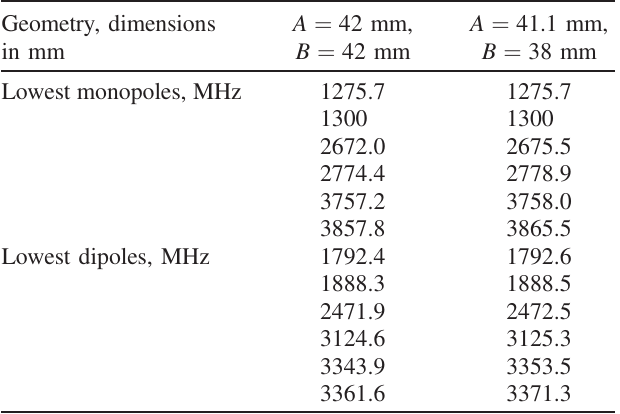
TABLE I. Frequencies of higher order modes for geometries specified in Fig. 8: original TESLA cavity and its modification without increasing magnetic field. Smaller elliptic half-axes are kept same: a ¼ 12 mm, b ¼ 19 mm. Bigger half-axes A and B are seen in the